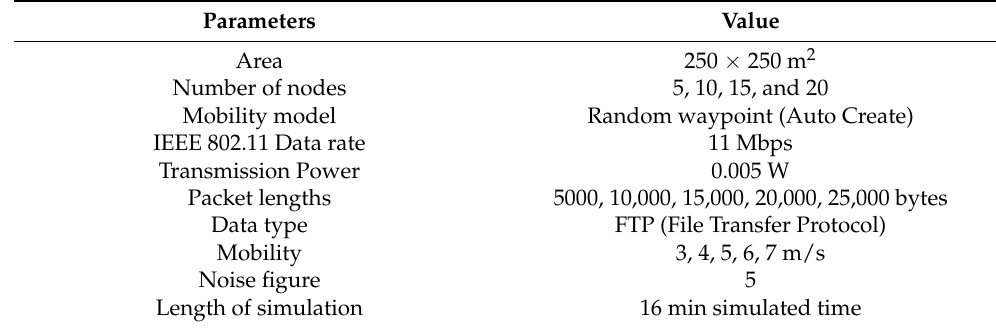
Table 2. General parameters used in the